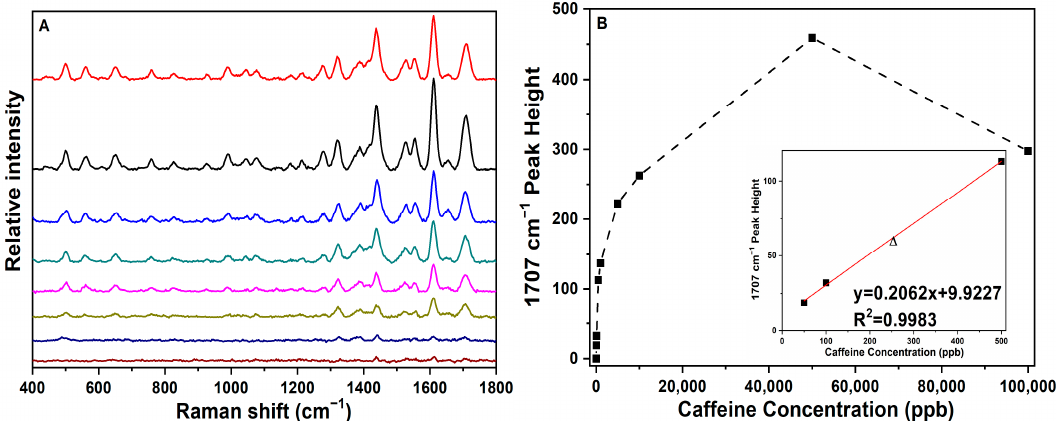
Figure 3. ( A ) SERS stacked plot of caffeine at 100 ppm, 50 ppm, 10 ppm, 5 ppm, 1 ppm, 500 ppb, 100 ppb, and 50 ppb (top to bottom) in water on SERS-active gold sol–gel capillaries; all SERS spectral conditions are the same as those in Figure 2. ( B ) Plot of 1707 cm − 1 peak height as a function of caffeine concentration corresponding to the spectra in ( A ) (solid squares connected by dashed line for clarity over the entire concentration range measured). The inset shows the linear fit used in the low-con- centration regime from the LMC at 50 ppb to the plateau point at 500 ppb. Triangle represents a 250 ppb caffeine test sample as an unknown.